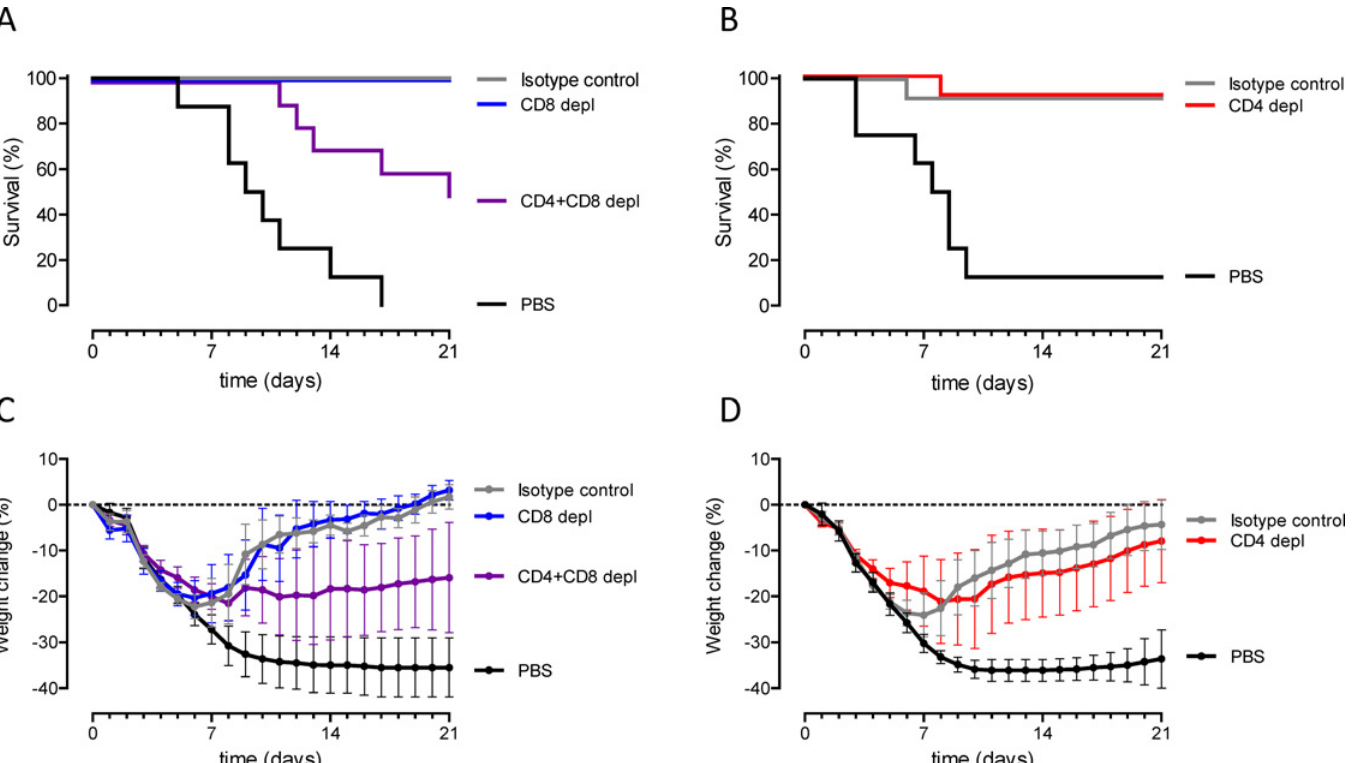
Fig 4. CD4 + and CD8 + T cells both contribute to H5N1 protection. Mice (n = 8-10/group) were immunized once with TVV+MM or PBS as negative control 4 weeks before challenge and (A) CD8 + or the combination of CD4 + and CD8 + T cells were depleted or (B) CD4 + T cells only were depleted with antibodies injected 4 days and 1 day before challenge. Mice were challenged with 12.5xLD 50 of wild type H5N1 A/Hong Kong/156/97 and monitored for 21 days for (A and B) survival and (C and D) bodyweight-loss. Graphs A and B represent the Kaplan-Meier survival curves and graphs C and D represent mean bodyweight change with 95% confidence